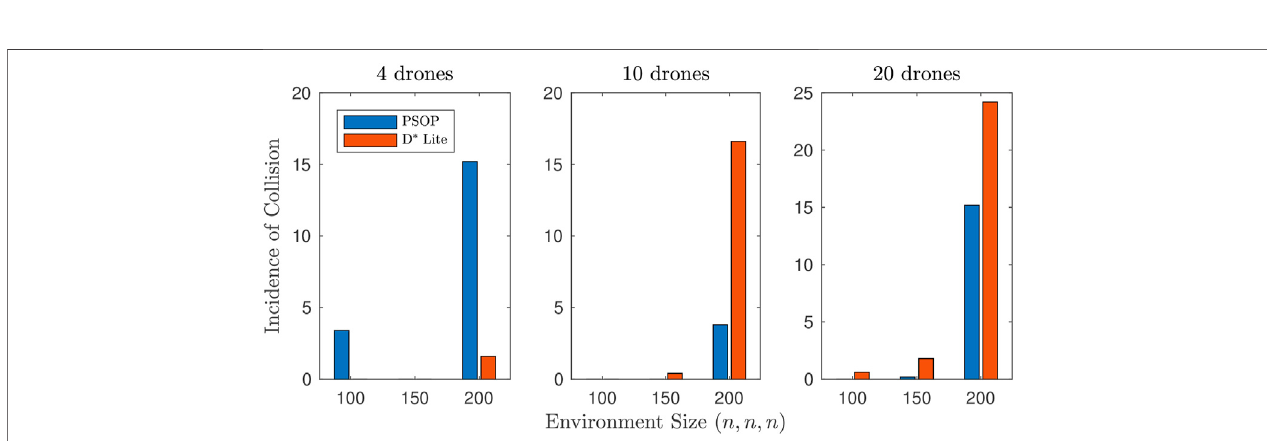
FIGURE6| Meantimetakentocompleteobjectivebyenvironmentsize.Forasystemof4drones,p-dronesrequiredlongertocompleteobjectivesthand-drones; whereas for systems of either 10 or 20 drones p-drones required less time to complete objectives when compared to d-drones. For 4 drones the PSOP method takes longer than D* Lite; however, this trend is reversed for 10 and 20 drones.